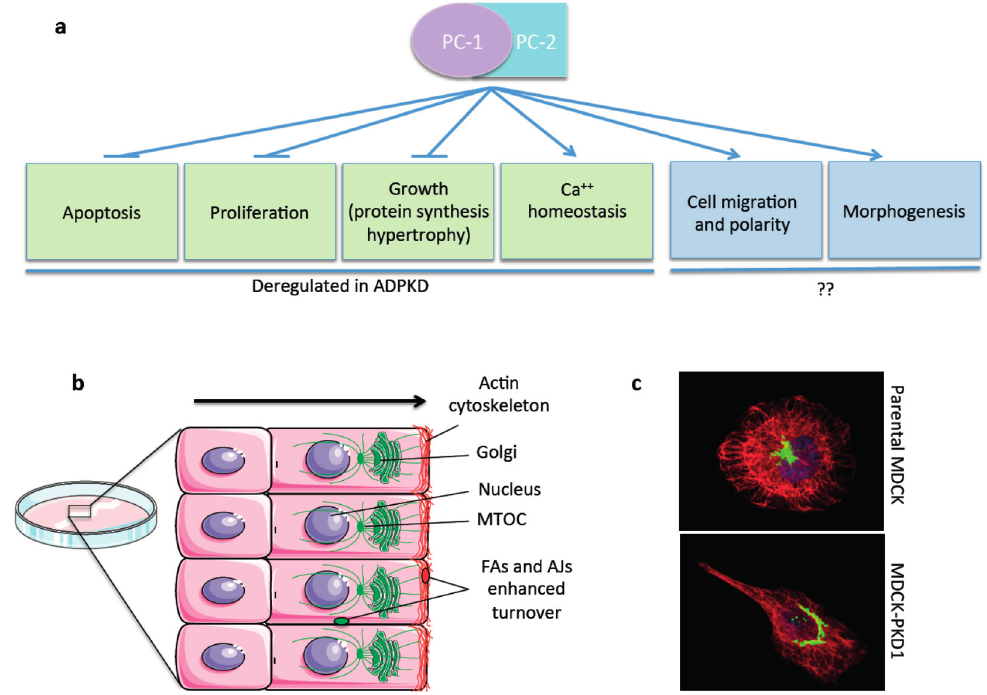
Figure 4. The Polycystins in Cell Migration. PC-1 and PC-2 are involved in